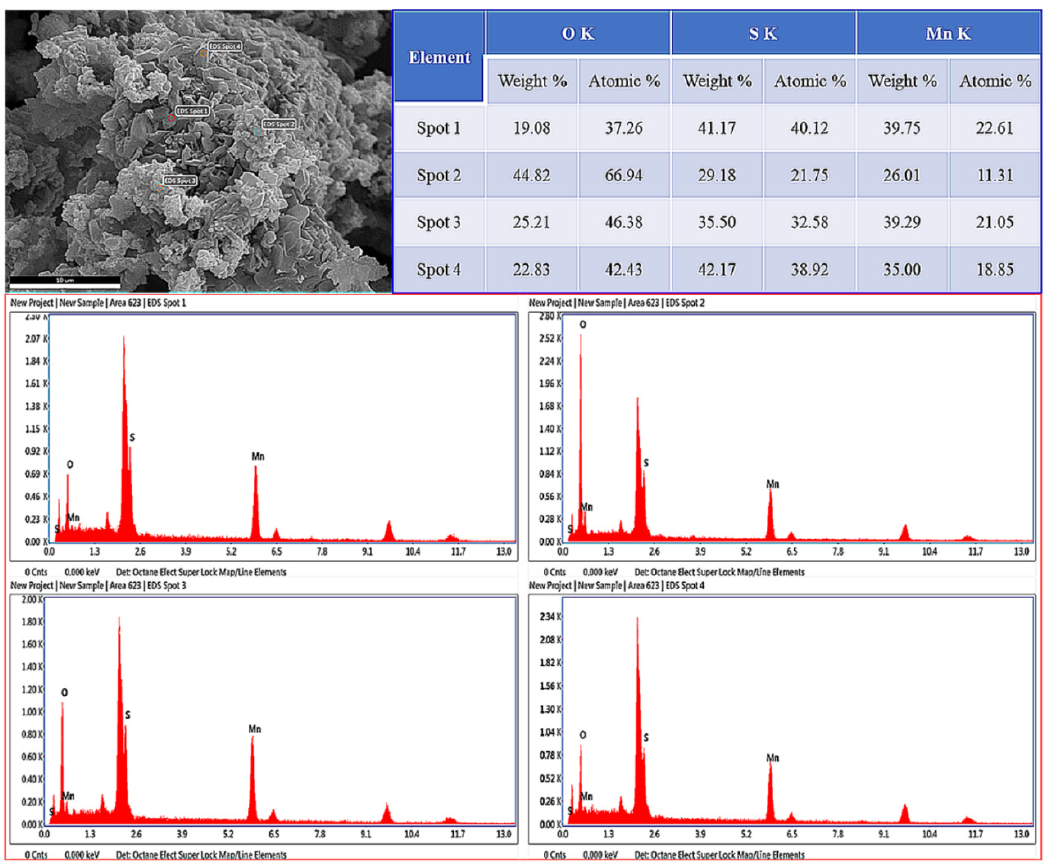
Figure 9. EDS results of the samples roasted at 450 °C (S 2 /MnO 2 = 0.25, 30 min).